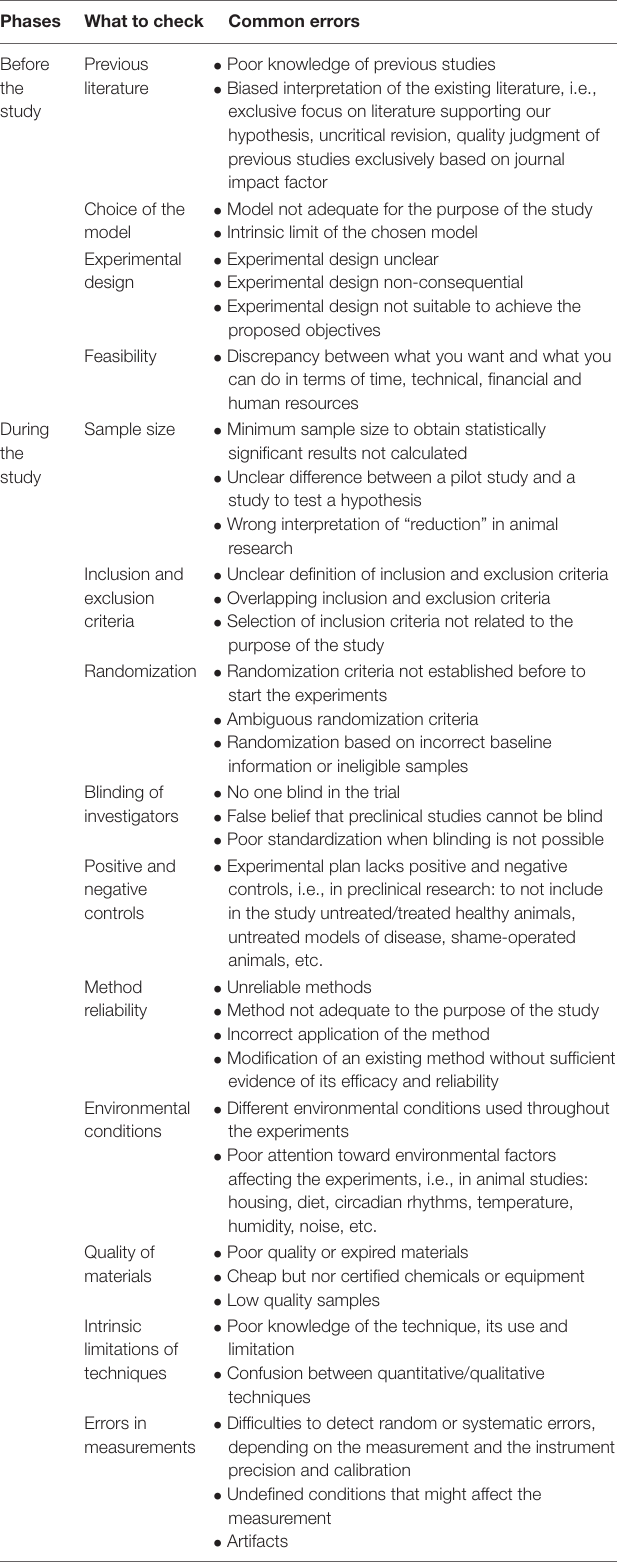
TABLE 1 | Common errors made in the different phases of an experimental